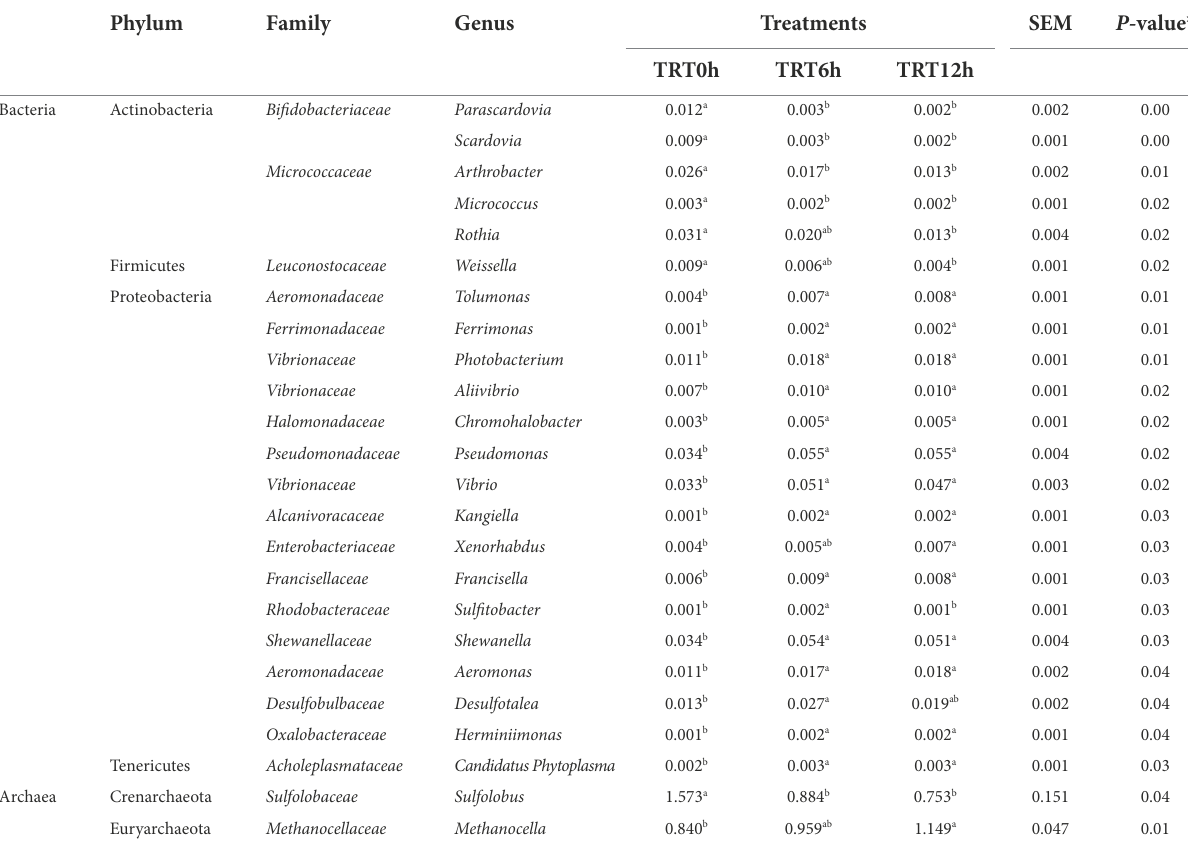
TABLE 2 Comparison of the relative abundance of bacterial genera among calves fed colostrum immediately after birth (TRT0h, n = 7), at 6 h after birth (TRT6h, n = 8) and at 12 h after birth (TRT12h, n = 9).